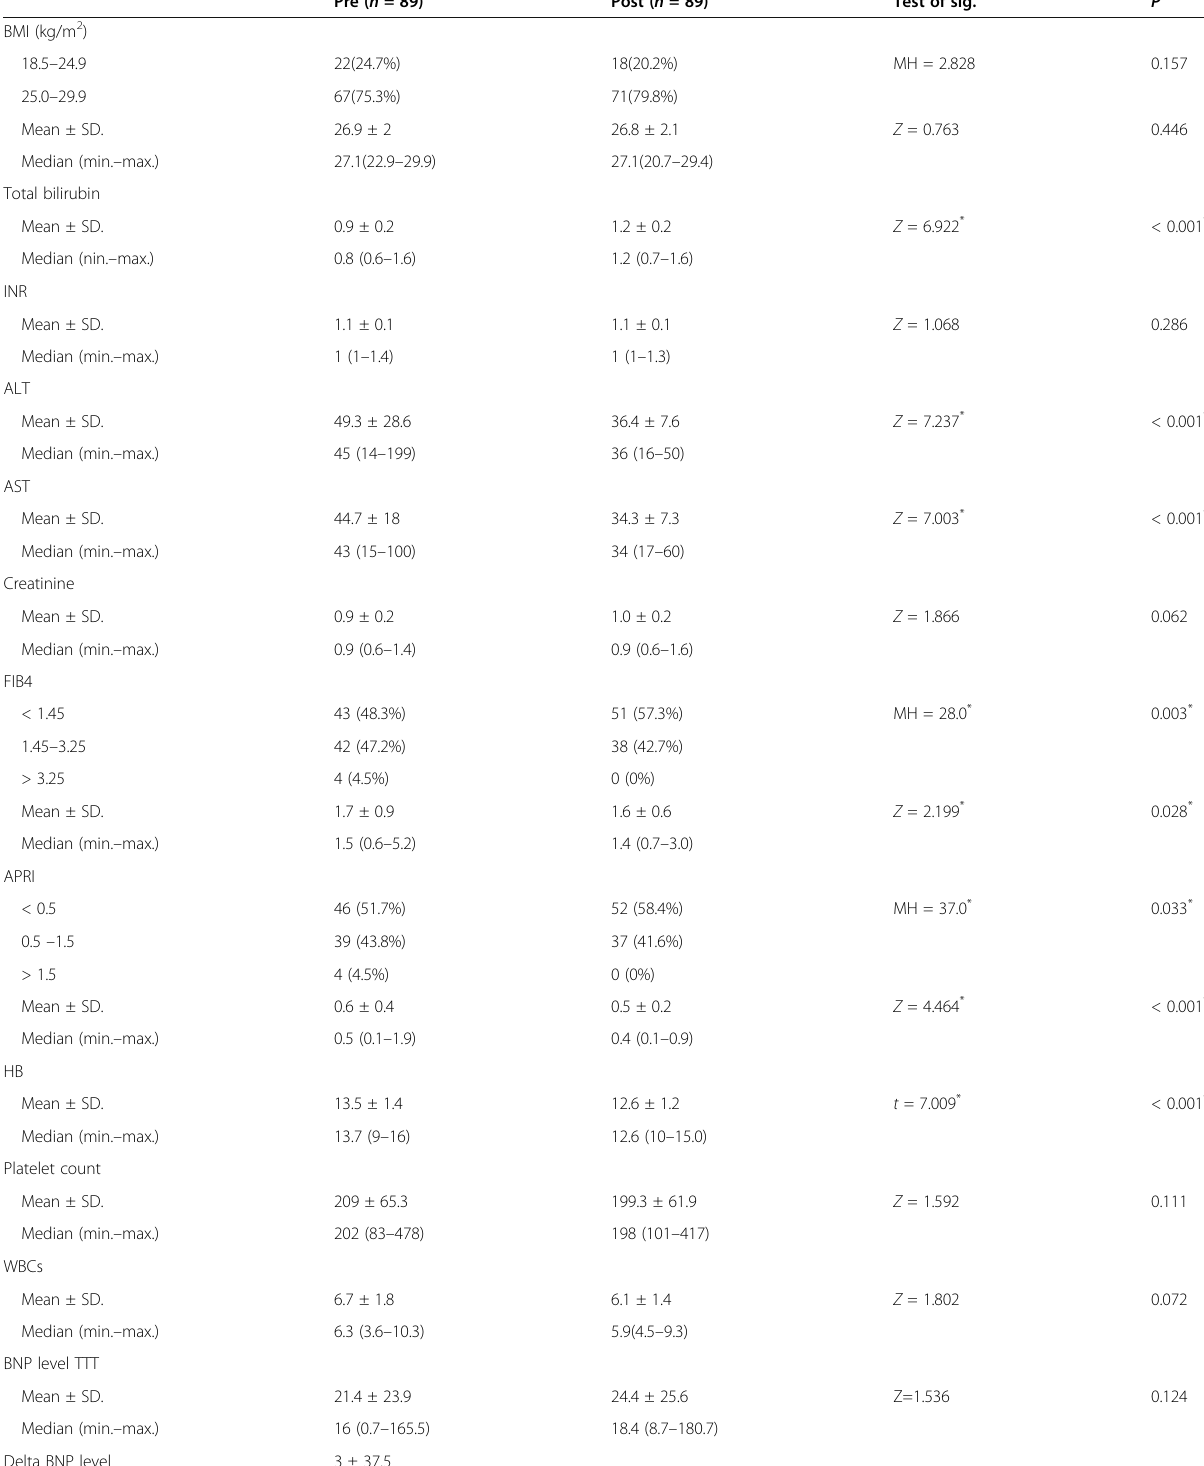
Table 2 Comparison between pre and post-treatment according to different clinical and laboratory parameters Pre ( n = 89) Post ( n = 89) Test of sig.